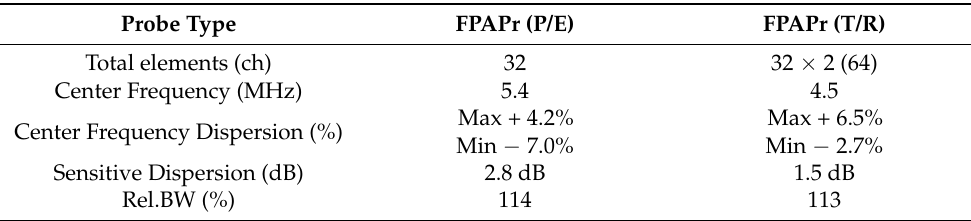
Table 3. Specifications of the FPAPr probes applied to the